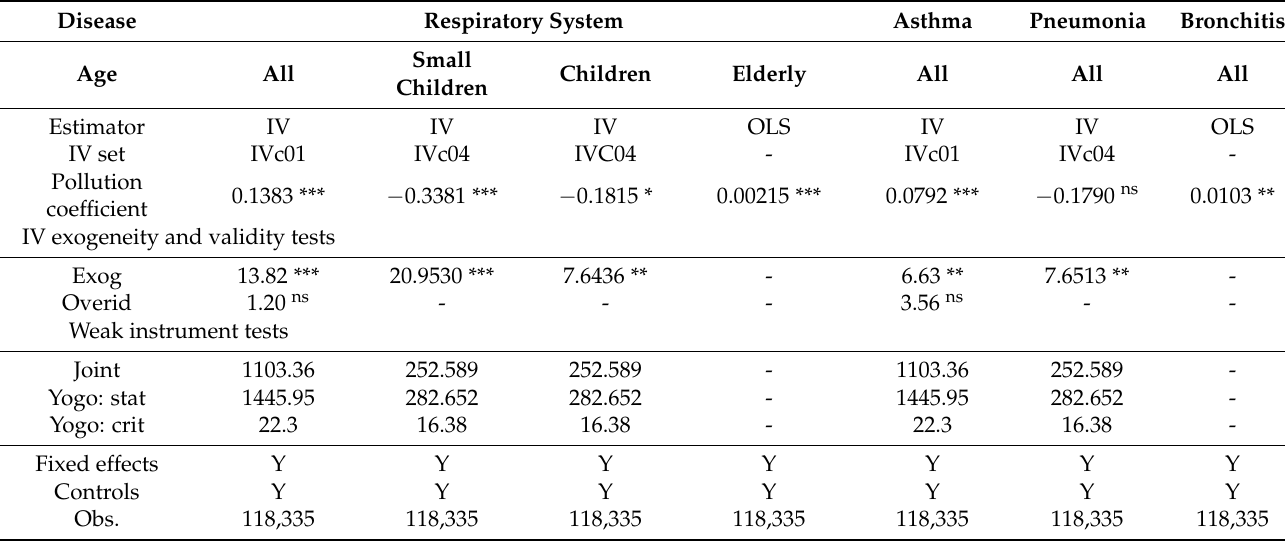
Table 4. Summary of estimates from the econometric specifications selected by the four-stage testing for each definition of the dependent variable.